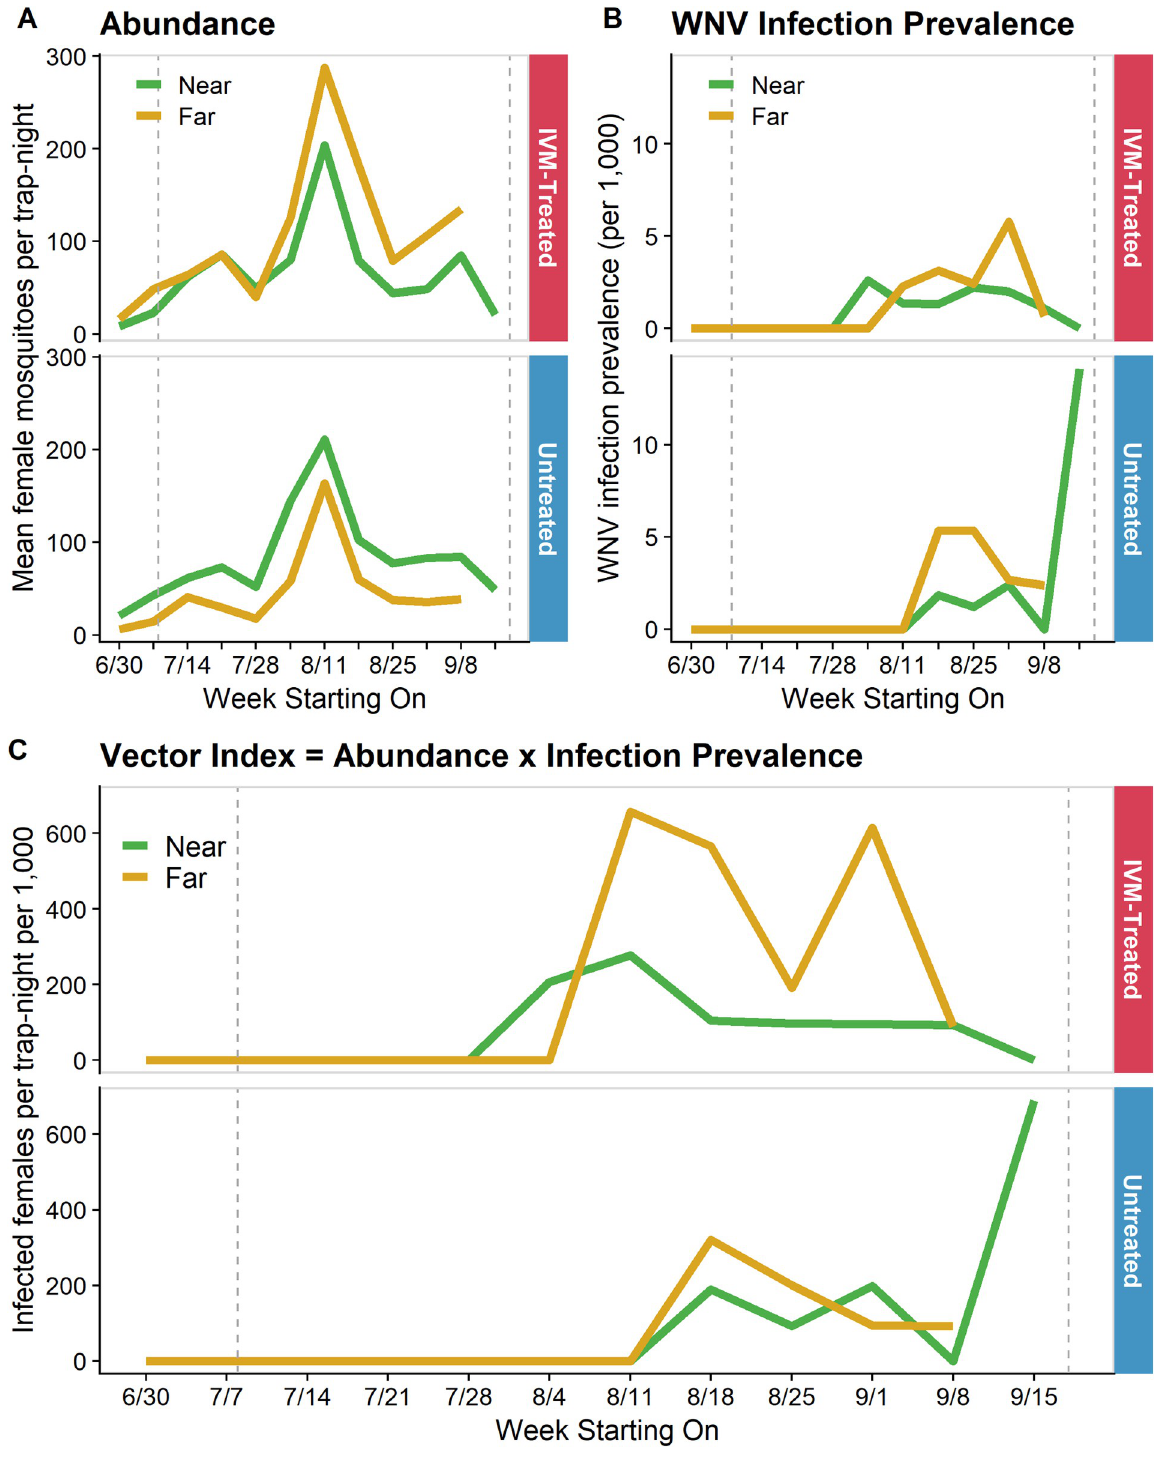
Fig 7. Entomological indices of Culex tarsalis around ivermectin (IVM)-treated and untreated chicken flocks. Weekly (A) abundance, (B) infection prevalence per 1,000, and (C) vector index (VI) near ( � 10m) and far (~150m) from IVM-treated and untreated flocks. VI is a risk metric that approximates the number of infectious mosquitoes present as the product of abundance and infection prevalence. Vertical dashed lines indicate the first and last day IVM-treated feed was provided.